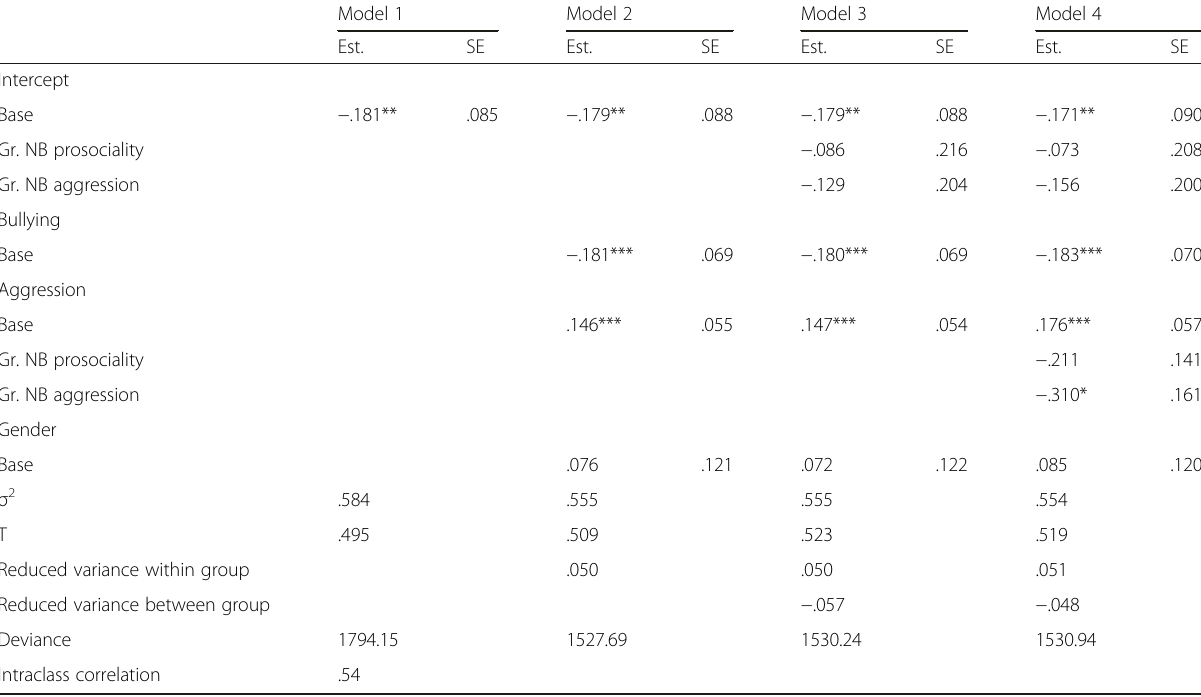
Table 2 HLM models regarding the effects of individual bullying, aggression, gender, and group normative beliefs about aggression and prosociality on individual